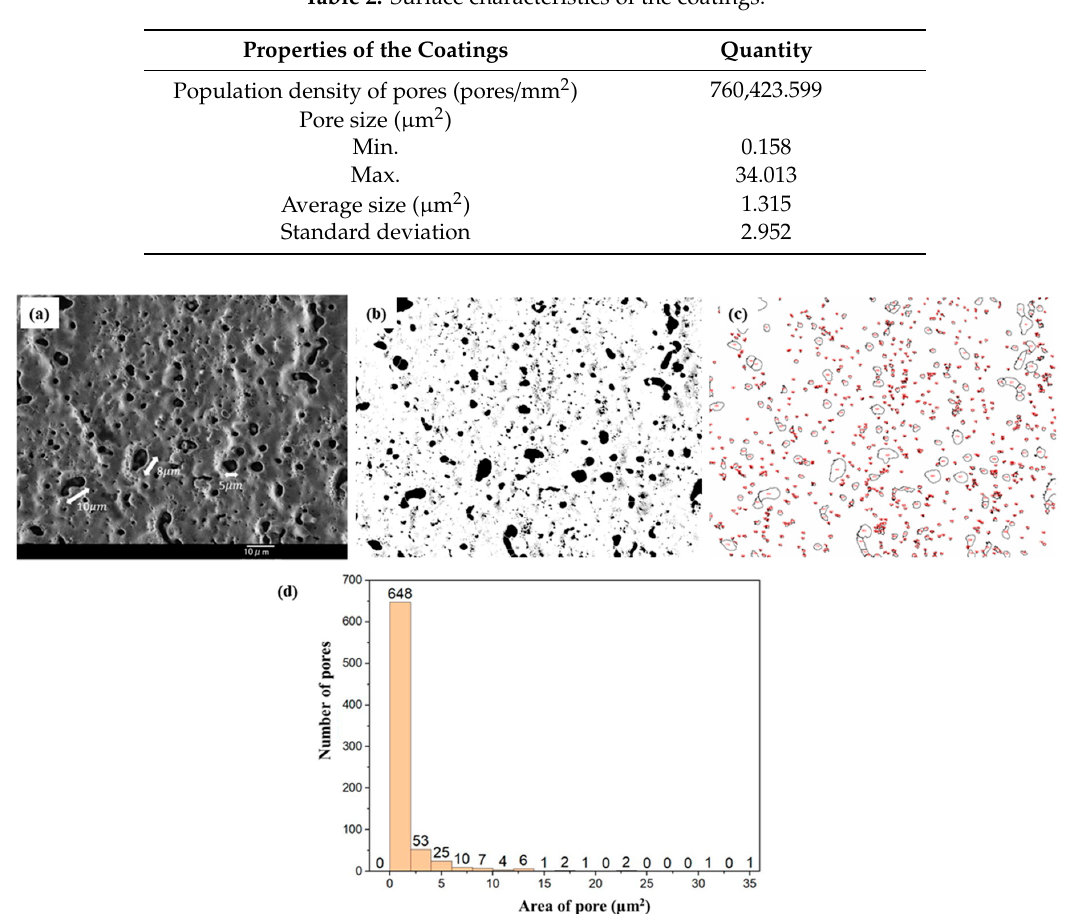
Figure 5. Image analysis to measure the population density of pores: ( a ) original image; ( b ) thresholded image; ( c ) segmentation after using the built-in Analyze Particles Image J plugin; and ( d ) histogram of pores distribution.